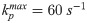
Membrane deformation in the regime of progressive gel.(a) Initial (b) early and (c) late configuration of the membrane and gel for na = 0.1 nm−1, Fe = 12 pN, kpmax=60s-1 and vgmax=10nms-1. The insets in panels (a)-(c) show the filaments status underneath the membrane. The blue lines represent the free fluctuating filaments while the black lines show the attached filaments. (d) Behavior of the middle-point of the membrane versus time. The little arrows show the points where the data for the (a)-(c) plots are collected.